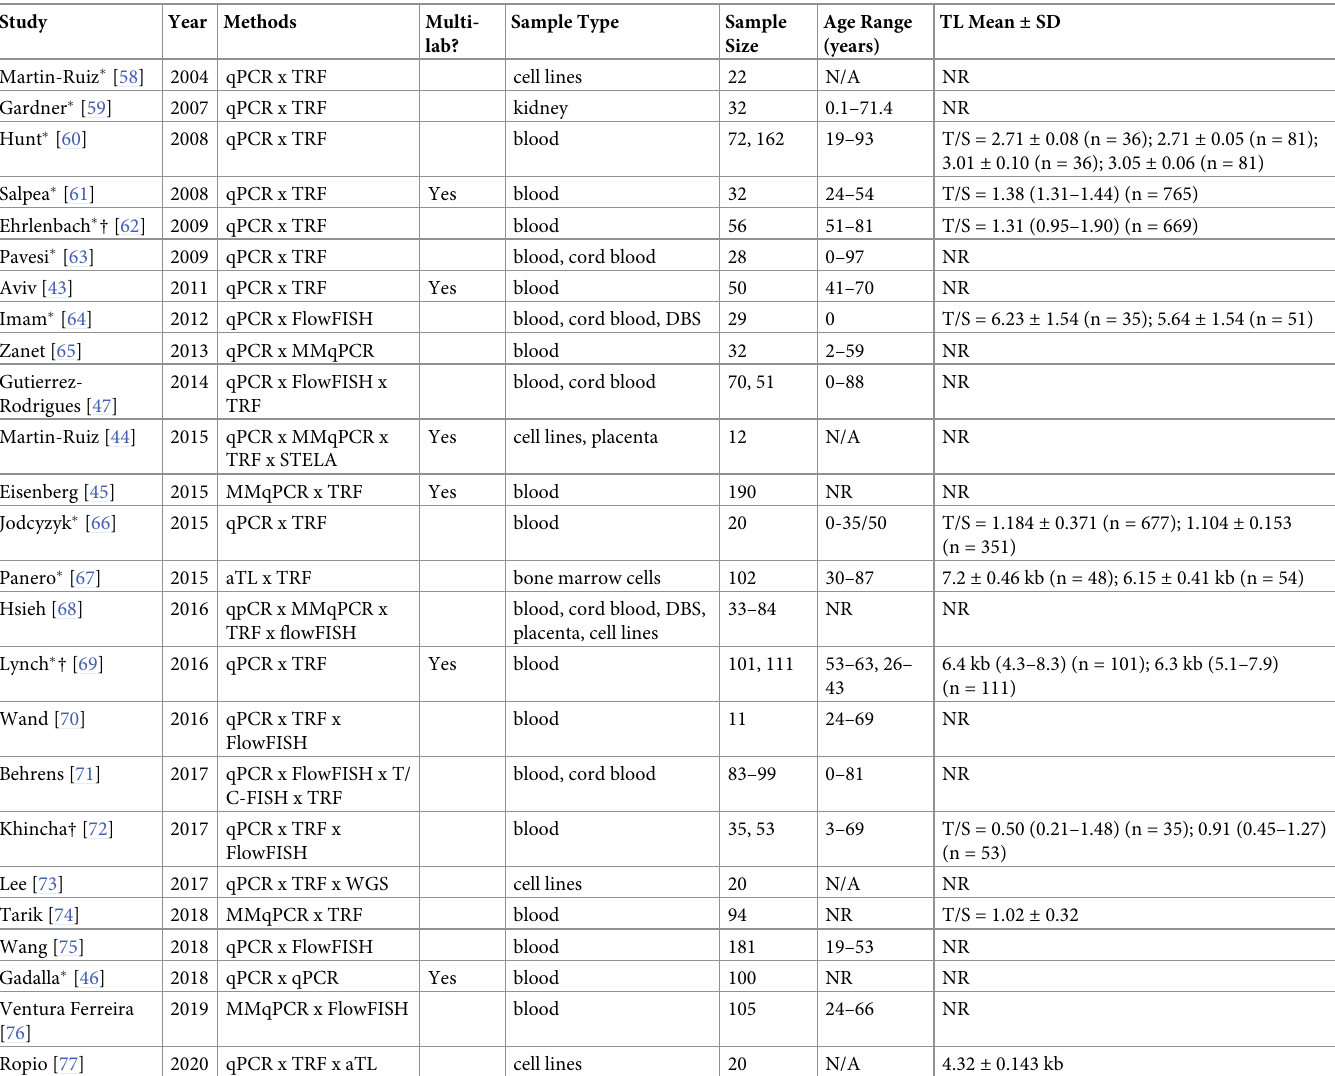
Table 1. Characteristics of included